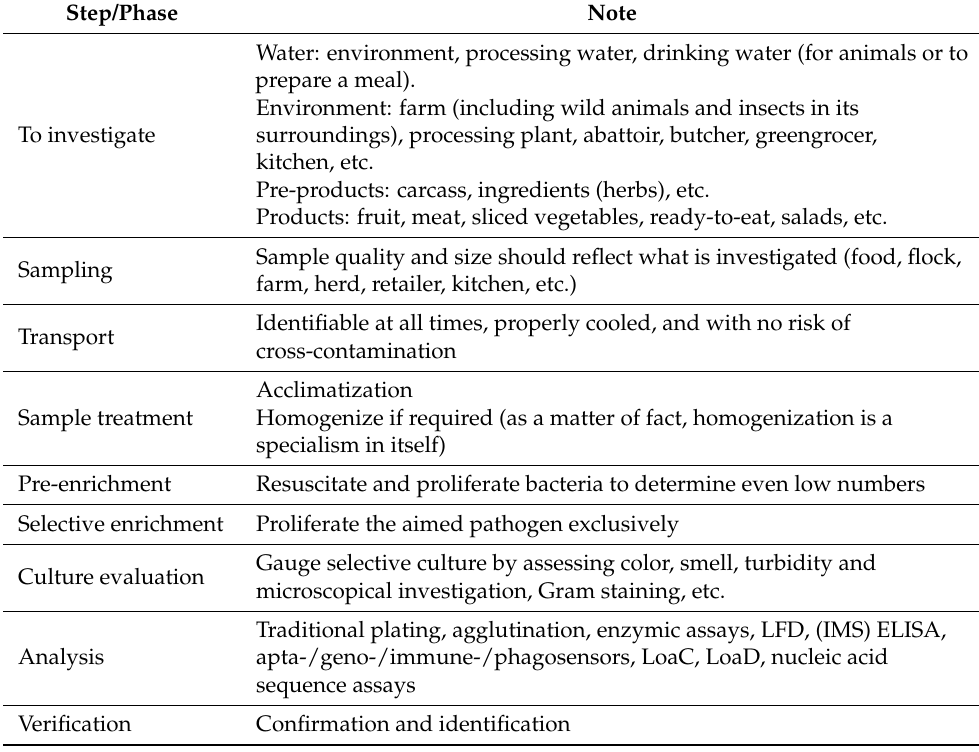
Table 2. Steps and phases in an analytical procedure determining a bacterial pathogen which can cause foodborne infections (adapted from [109]). These steps involve prevalently those for direct antigen